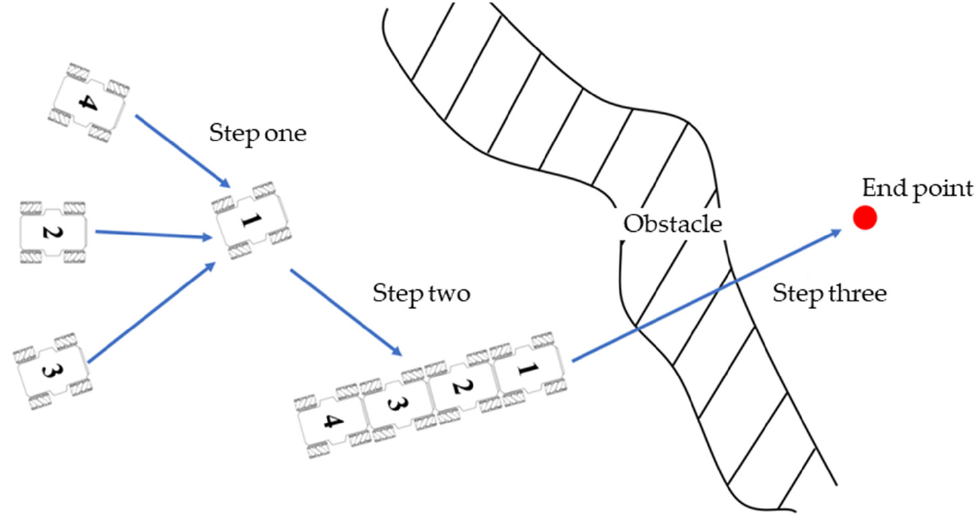
Figure 12. Modular vehicle group crossing obstacles .